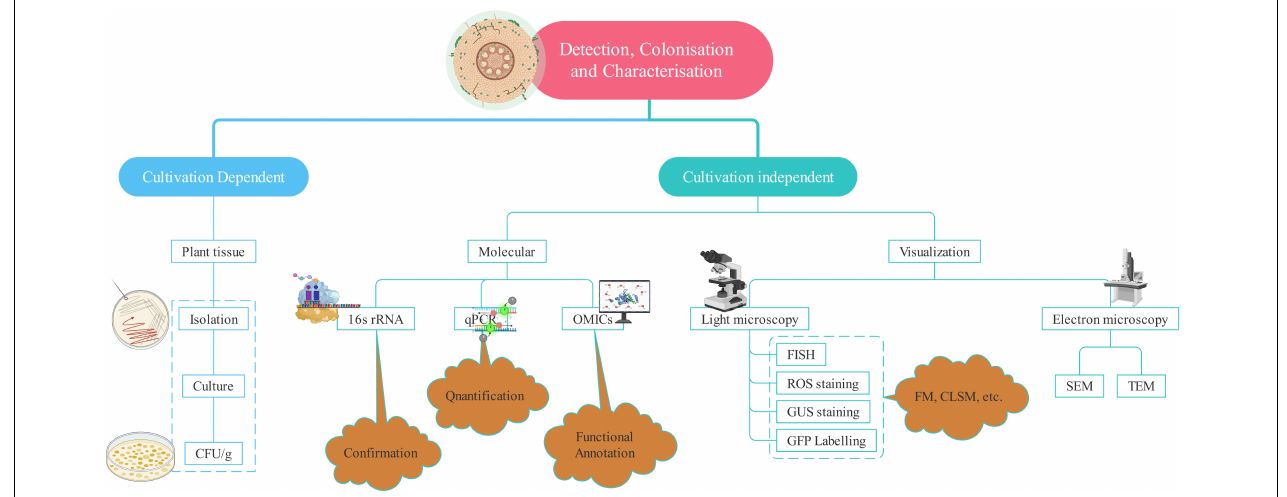
FIGURE 2 | Techniques used for the detection of endophytism.